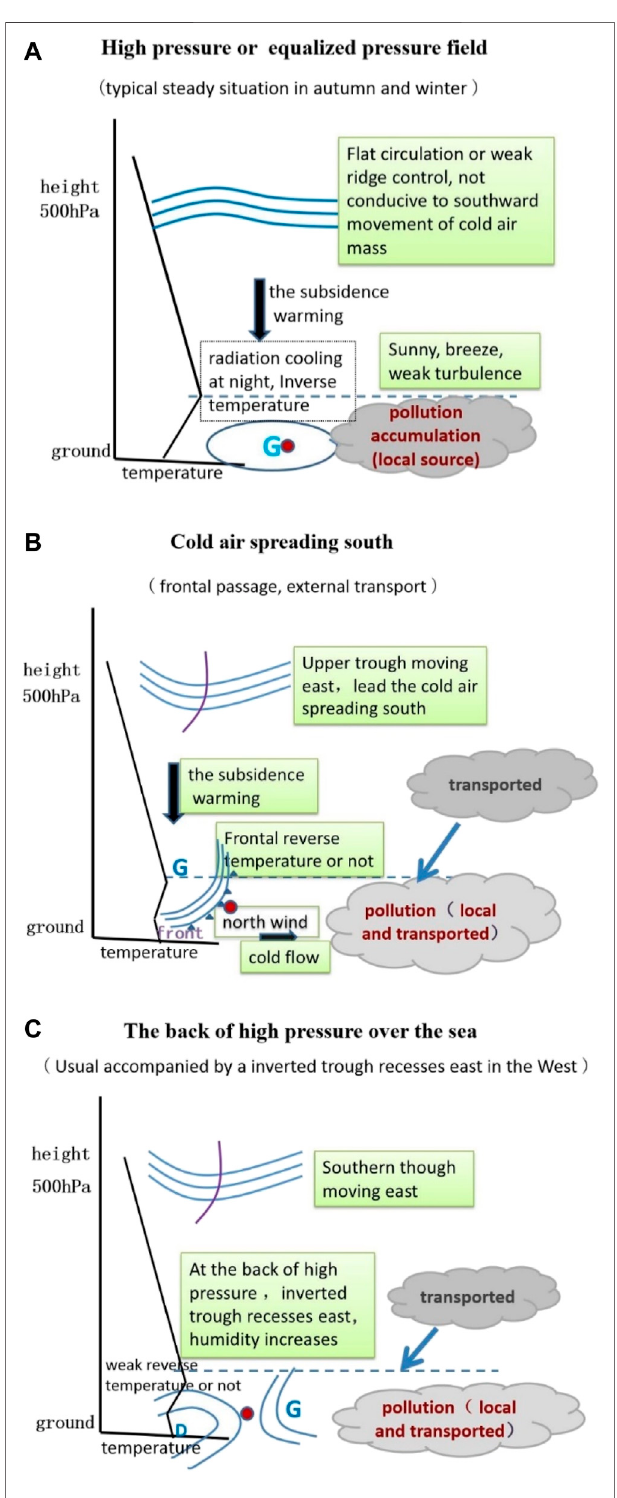
FIGURE4| Three types of high- and low-level circulations on fog-haze days in theJianghuai area. (A) High pressure or equalized pressure fi eld, (B) cold air spreading southward, and (C) The back of high pressure over the sea.